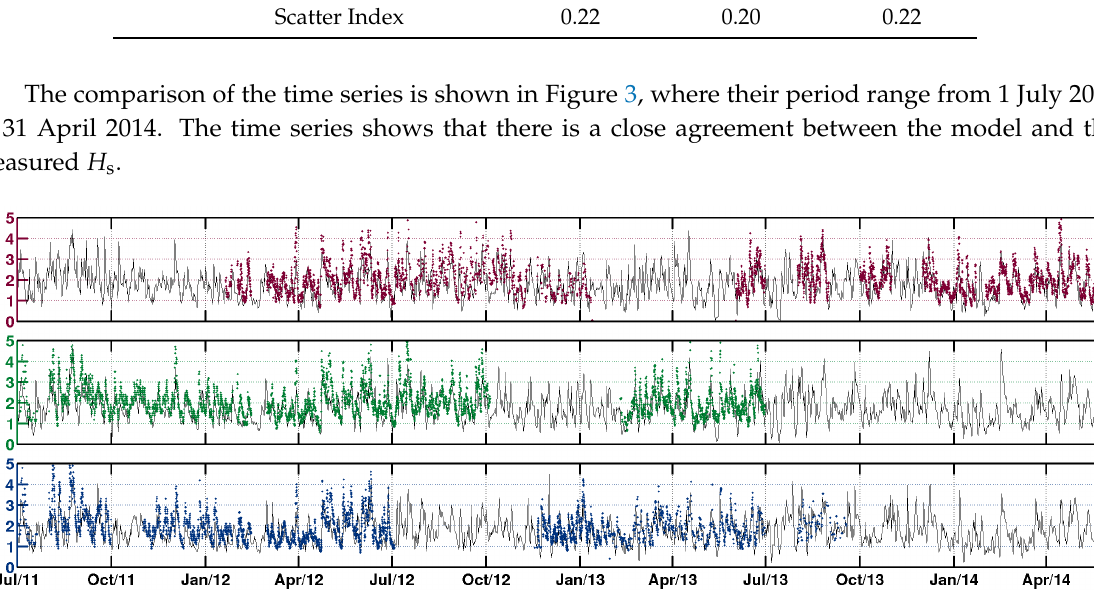
Figure 3. H s time series from T OMAWAC (black lines) and measured data (coloured dots) from the wave buoy located off the coast of: ( top ) Rio Grande do Sul; ( middle ) Santa Catarina; and ( bottom ) São Paulo (sampled at a three-hourly